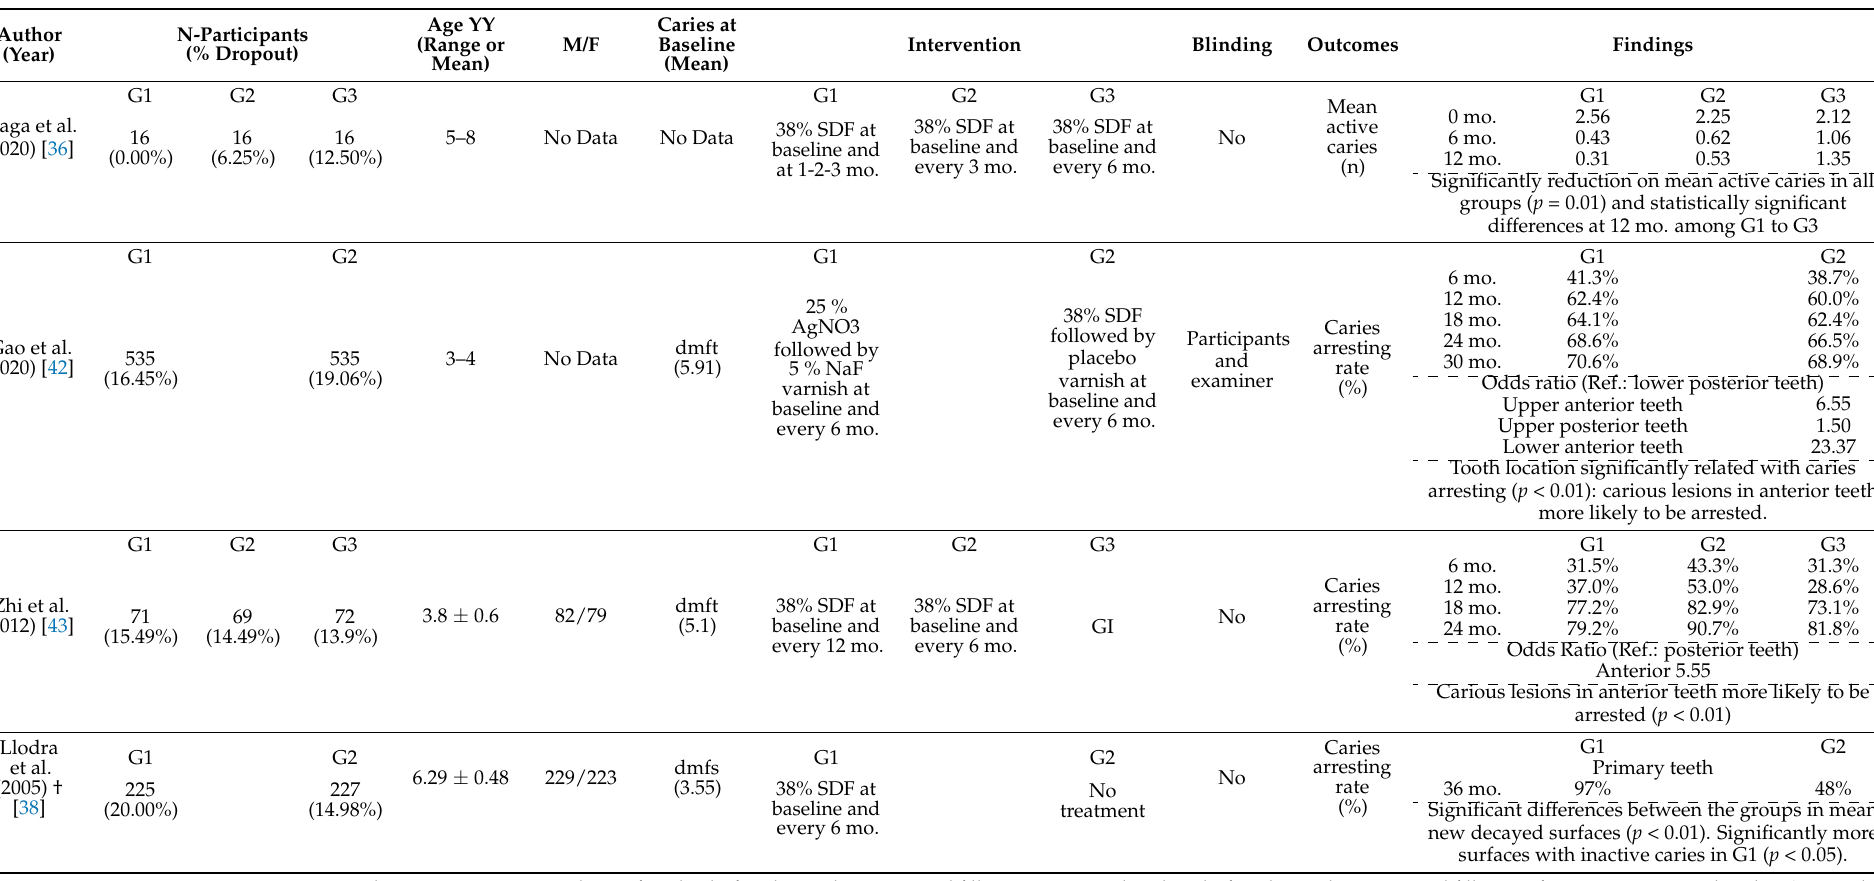
Table 3. Main characteristics of the studies not included in meta-analysis (results rounded up to 1 decimal when 2 decimals were not